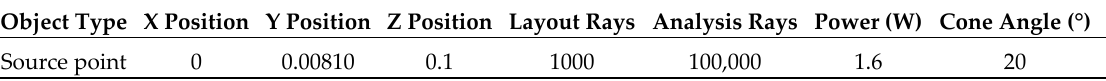
Table 2. Parameters used for the light source ( Zemax ® units—millimeters).